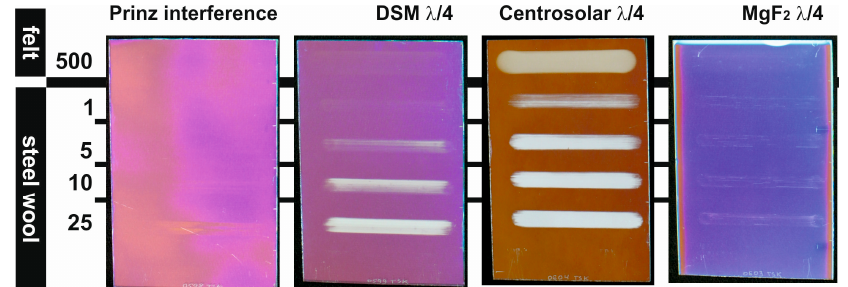
Figure 9. Photographs of antireflective coatings subjected to Crockmeter testing using felt (500 cycles) and steel wool (1–25 cycles) as abrasive. The size of the samples shown is 10 × 15 cm². Reproduced from Reference [42] with the permission of the Royal Chemical Society.